Question: Which visualization type does this figure use?
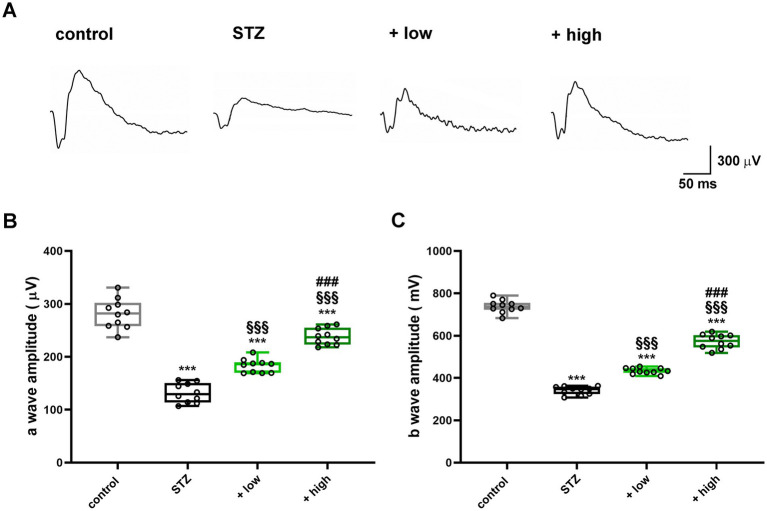
Answer: box